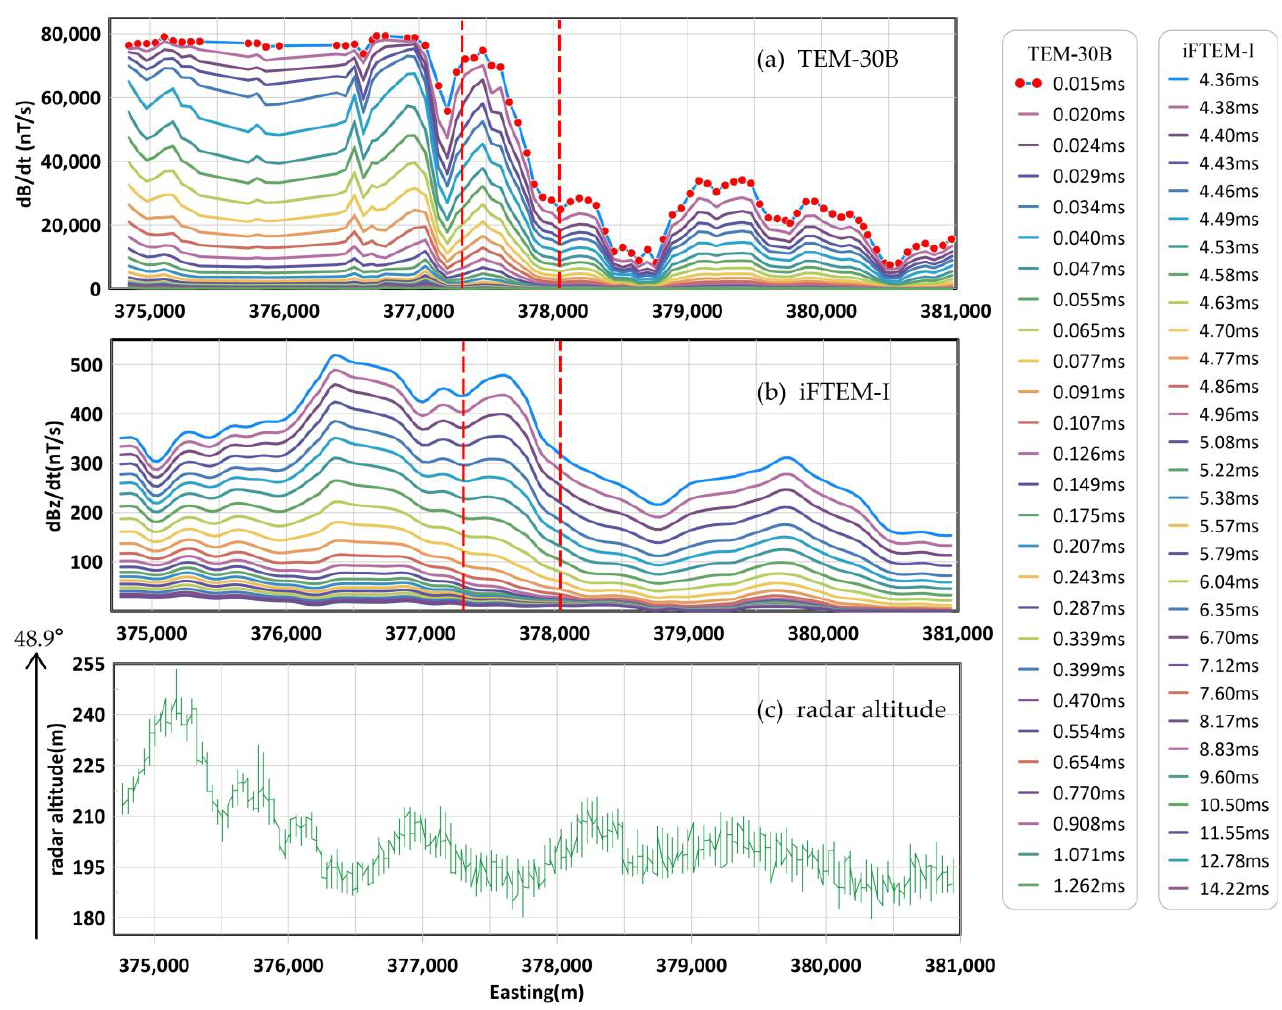
Figure 12. Comparison of profile response of L2100 between iFTEM and TEM-30B. ( a ) Profile response of TEM-30B (27 channels ahead); ( b ) profile response of iFTEM; ( c ) radar altitude of iFTEM. Between the red dash lines are the red rectangle areas from Figure 10.